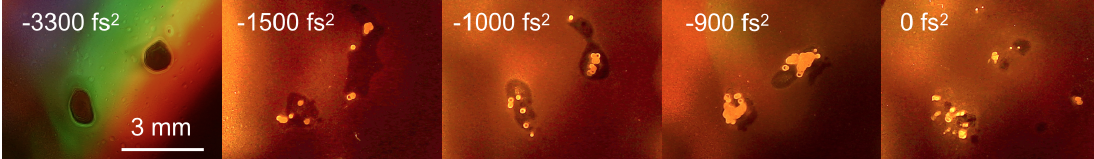
Figure 4. ( a ) Intensity of atomic (U I 591.54 nm) line and molecular (UO 593.55 nm) spectral band for various applied quadratic phase to incident laser pulse. The left inset is the laser beam profile before 10-m propagation through the air. ( b ) Frequency-resolved optical gating (FROG) traces and laser pulse parameters corresponding to the case of zero applied quadratic phase.